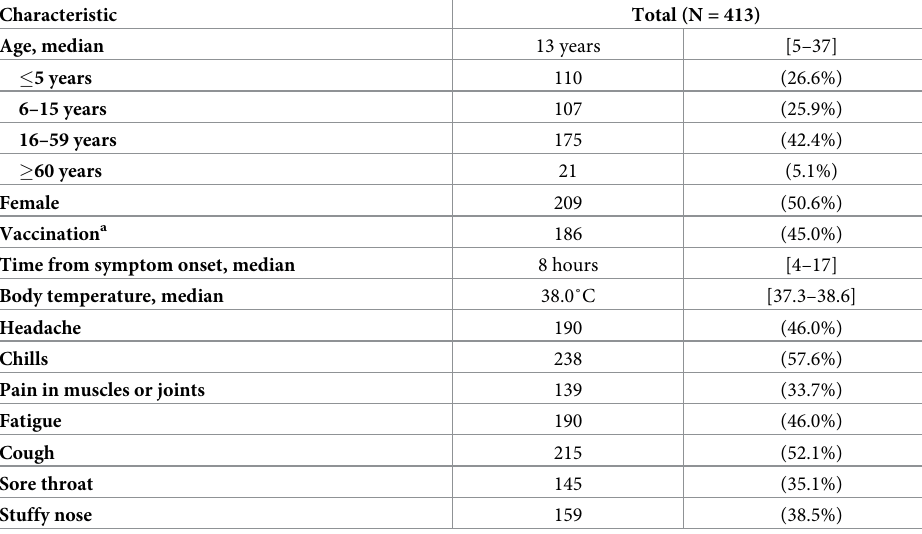
Table 1. Patient